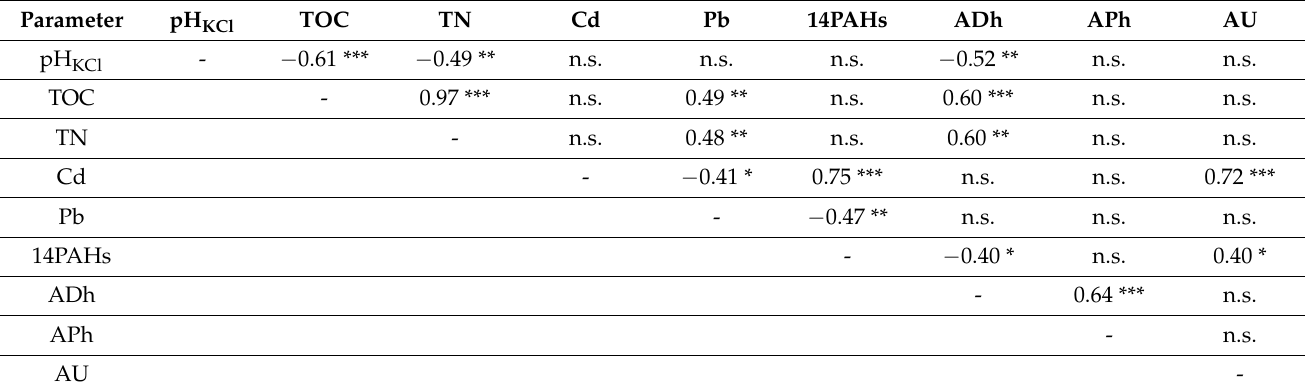
Table 12. Significant correlation coefficients between studied soil parameters (N =